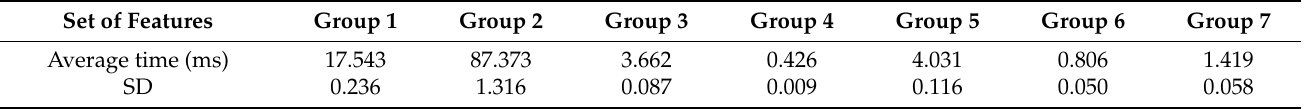
Table 1. Average time and standard deviation for determining parameter values for one gait cycle depending on parameter